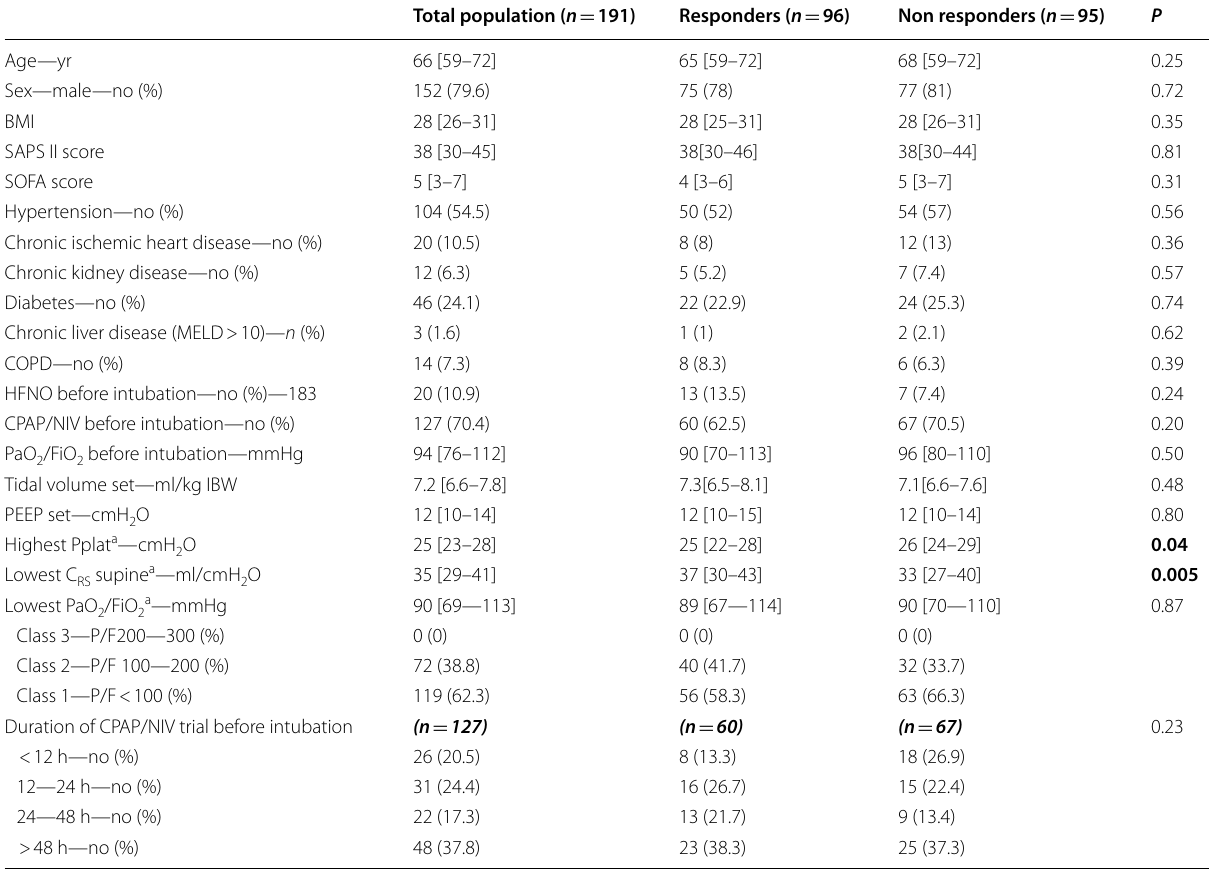
Table 1 Demographic data and clinical